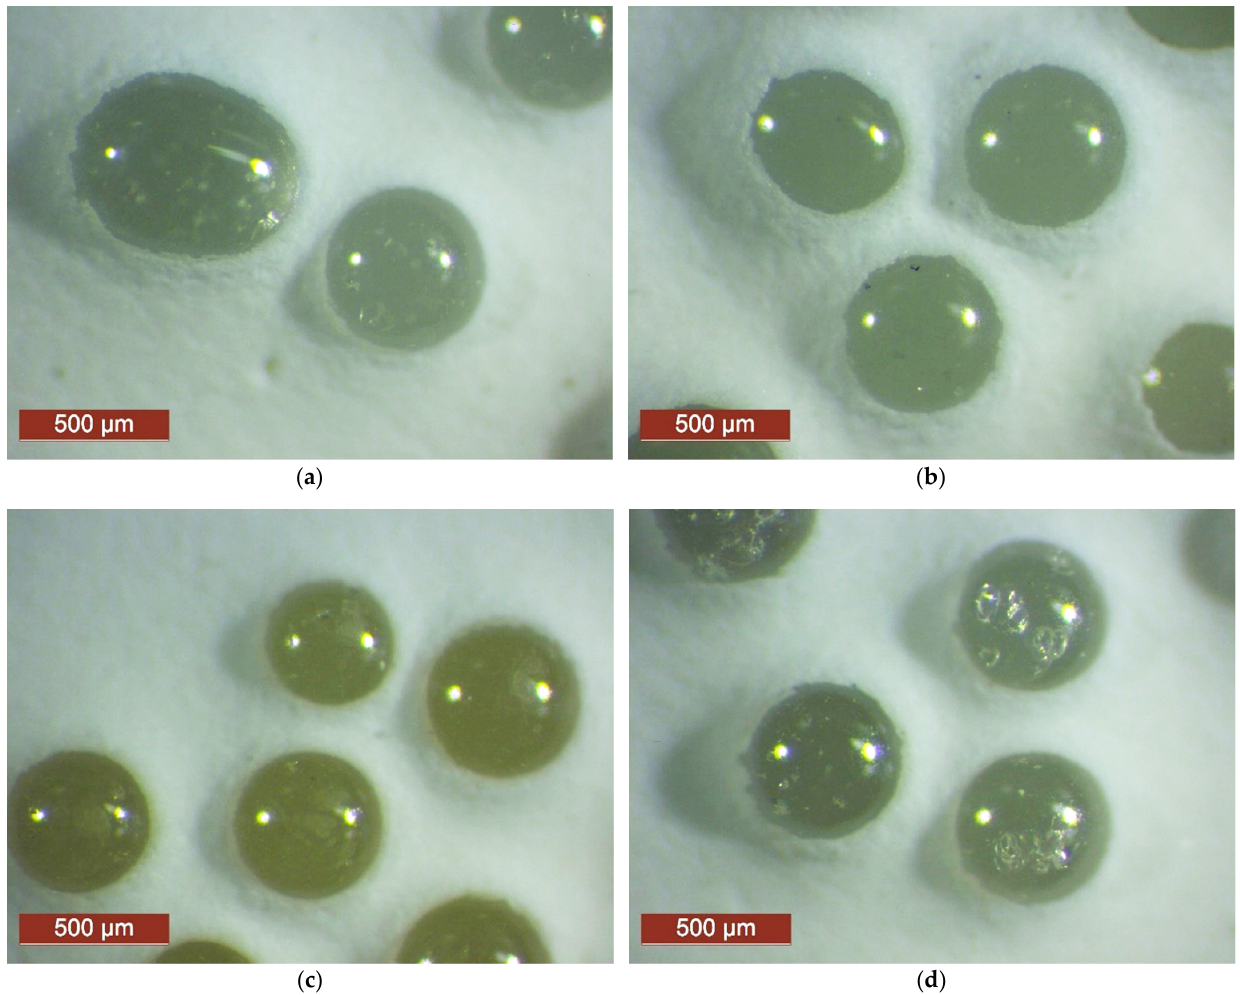
Figure 5. Microscope images (magnification 32×) of GB after exposure to 168 drum rotations with corundum: ( a ) standard (sample SF ), ( b ) large (sample ML ), ( c ) premium (sample SP ), ( d ) high index (sample HI ).